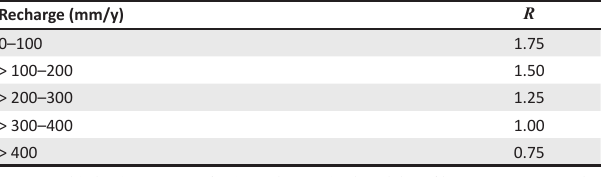
TABLE 3: Recharge rating of the PI protective cover.